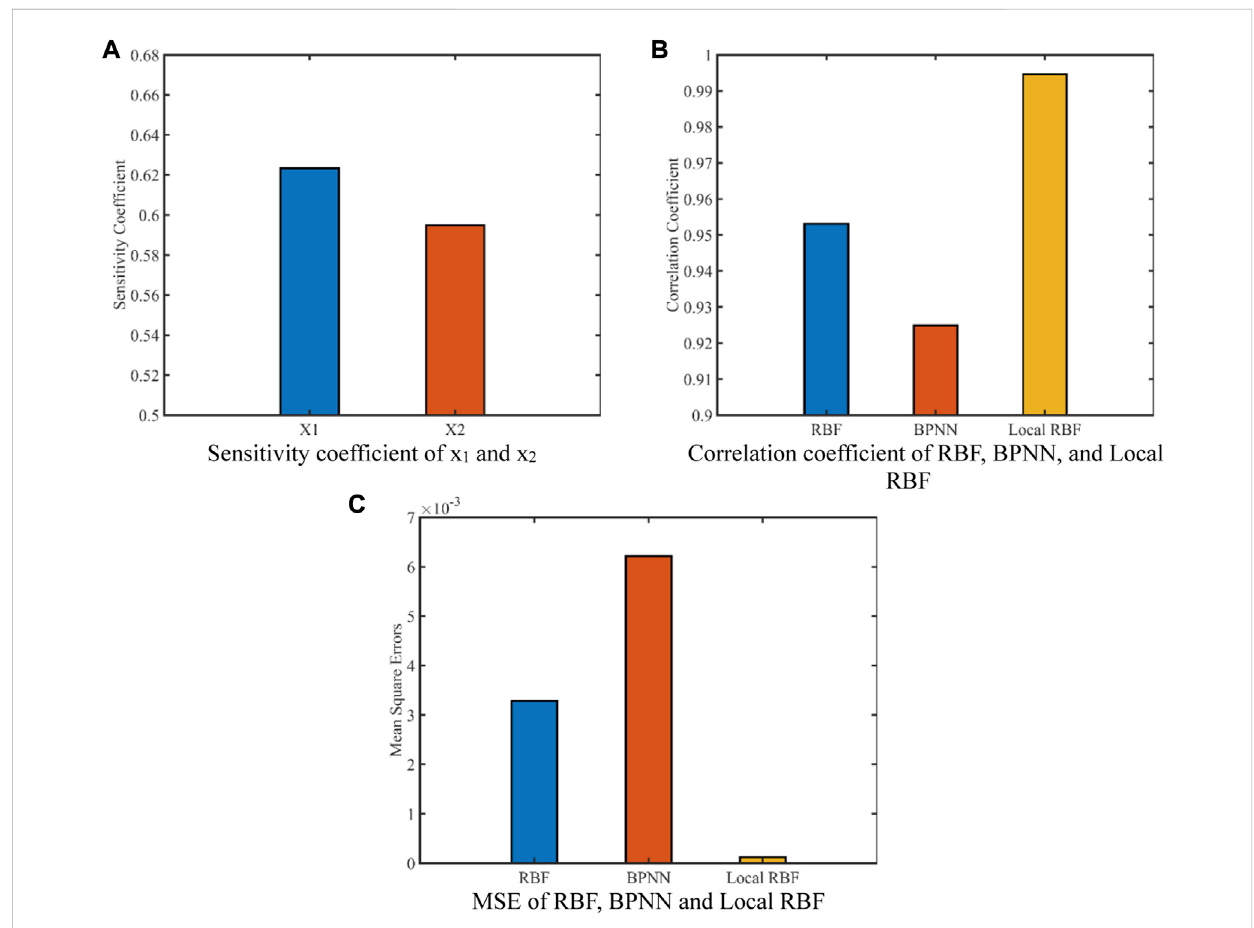
FIGURE 4 Display of benchmark function calculation results.